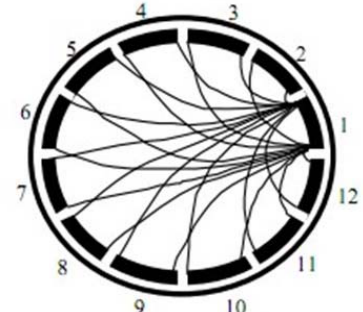
Figure 9. Overlapping sensing region between electrode 1 and other electrodes.